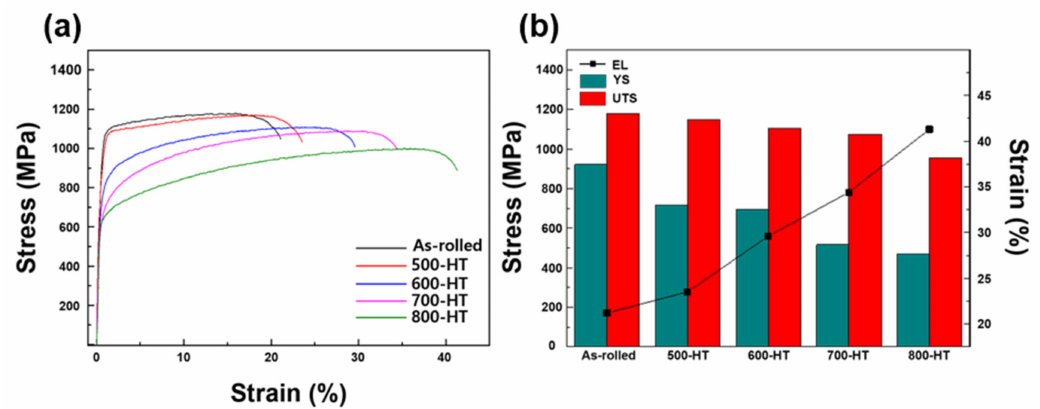
Figure 8. ( a ) Stress-strain curves and ( b ) yield strength (YS), ultimate tensile strength (UTS), and maximum elongation (EL) of Fe-SMA with different heat-treatment